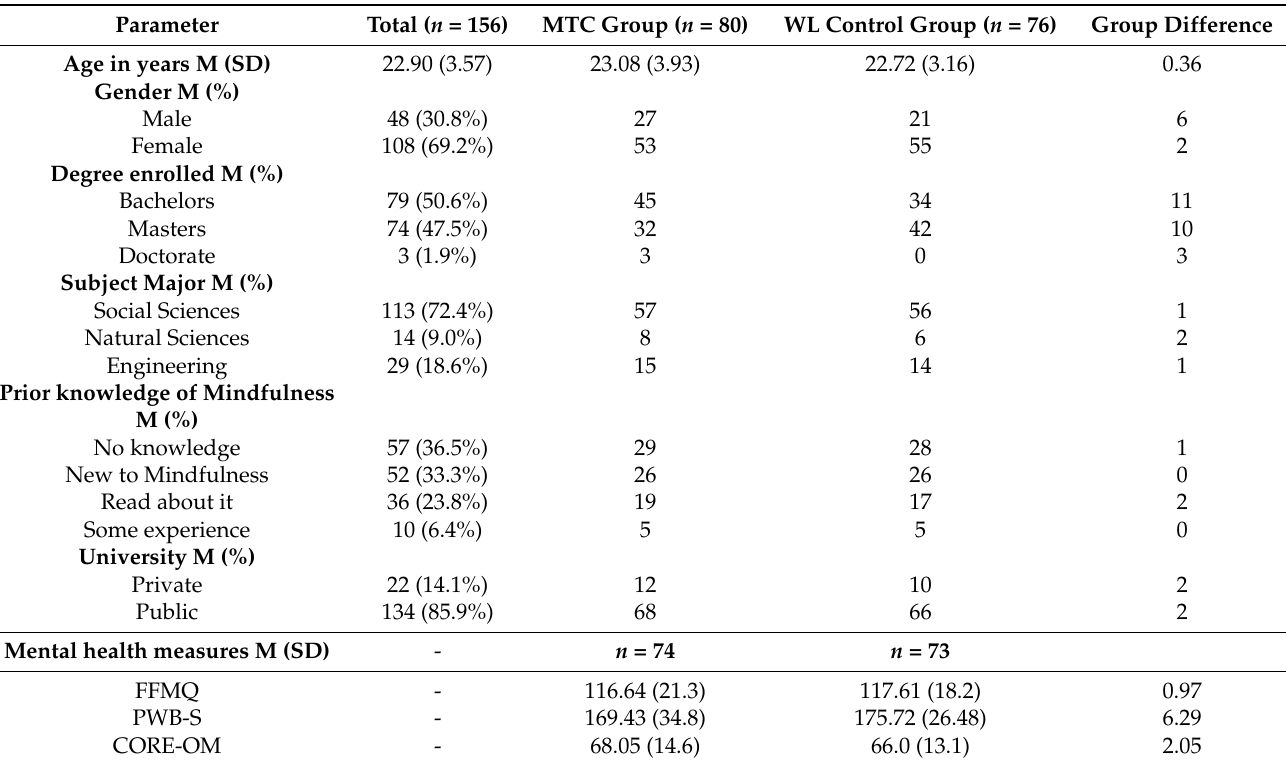
Table 1. Baseline information of the randomized